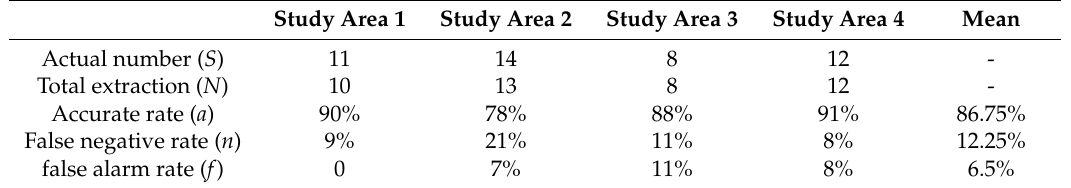
Table 5. Precision evaluation results of the automatic extraction of offshore